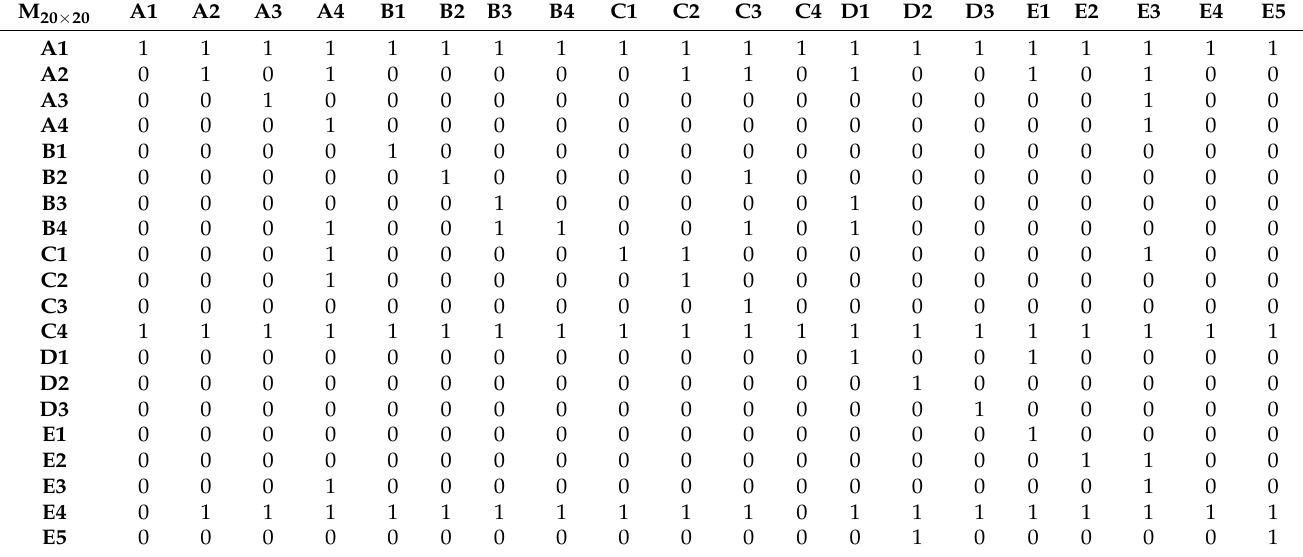
Table A2. Table of reachable matrix R table.